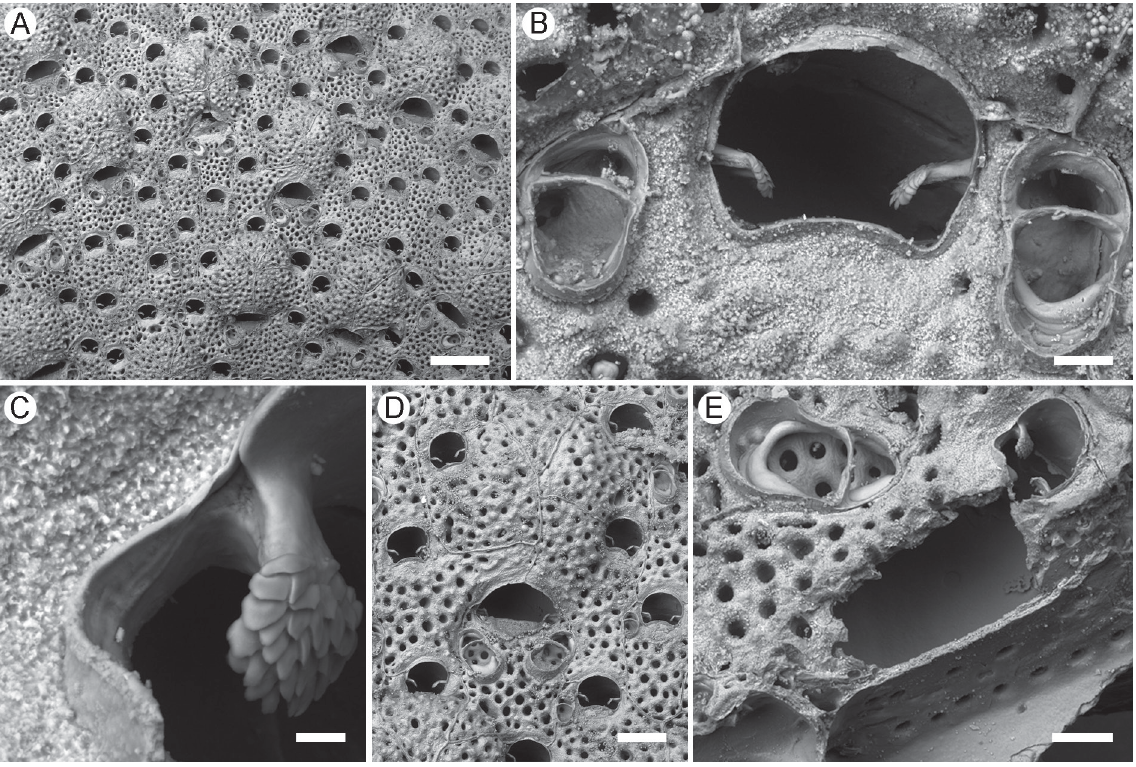
Fig. 1. Emballotheca quadrata (MacGillivray, 1880), NHMUK 1897.5.1.830, Recent, Port Phillip Heads, Victoria, Australia. A . General view of the colony. B . Autozooidal orifice and avicularia. C . Close-up of a condyle with scaled tip. D . Fertile zooid and surrounding autozooids. E . Large, spatulate, frontal avicularium and lateral pore-chamber windows in the vertical walls. Scale bars: A = 500 µm; B = 40 µm; C = 10 µm; D = 200 µm; E = 100